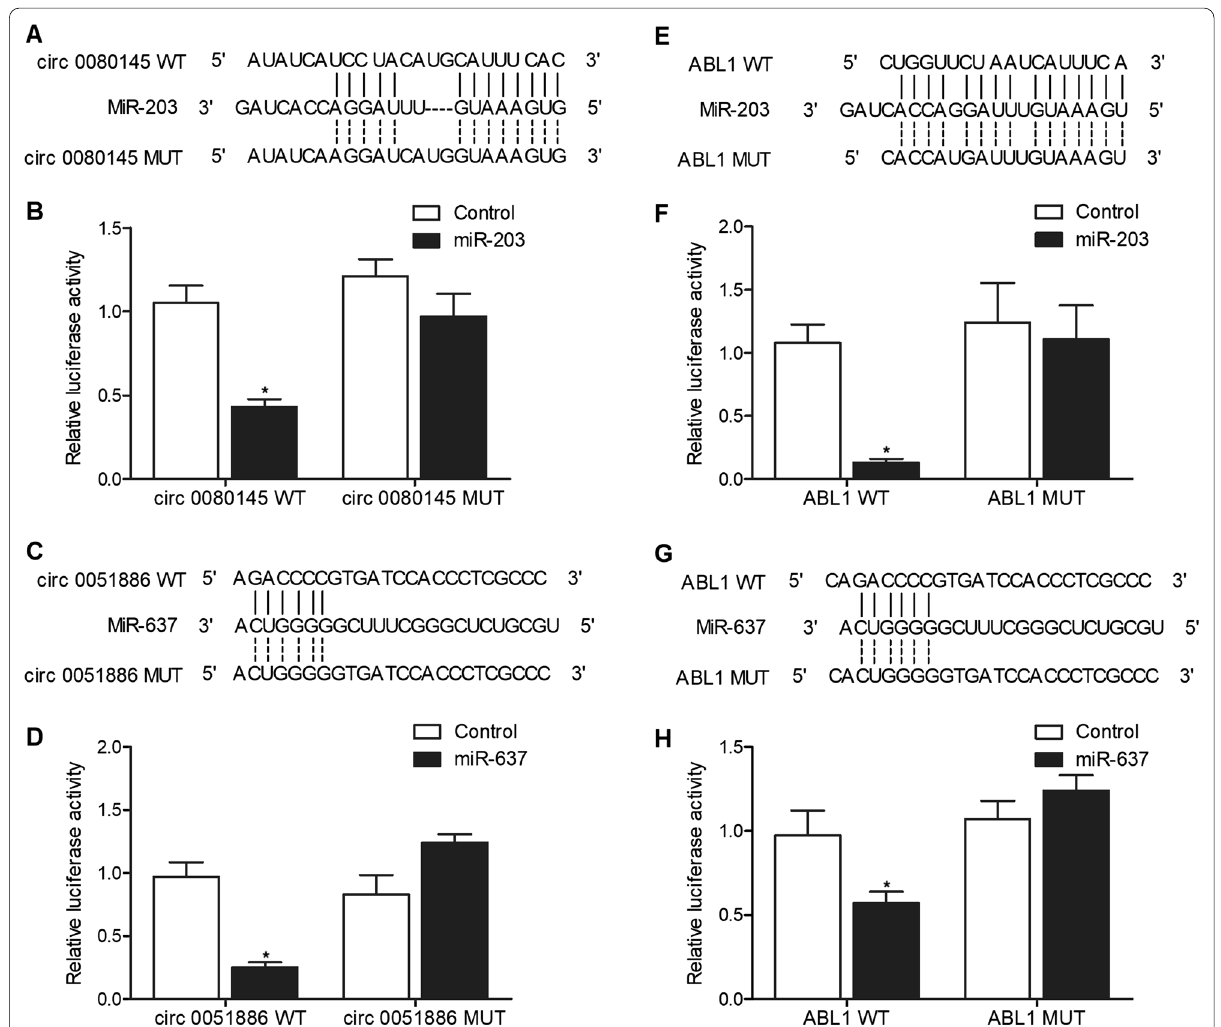
Fig. 3 The molecular relationships between circ_0080145, miR‑203 and ABL1, as well as circ 005188, miR‑637 and ABL1, were established via sequence analysis and luciferase assays (*P value < 0.05 vs. Control group). A A potential binding site of miR‑203 was found on circ_0080145; B Luciferase assay validated that circ_0080145 targeted miR‑203; C A potential binding site of miR‑637 was found on circ 0051886; D Luciferase assay validated that circ_0051886 targeted miR‑637; E A putative binding site of miR‑203 was observed on the 3 ʹ UTR of ABL1 mRNA; F Luciferase assay validated that ABL1 mRNA was a target of miR‑203; G A putative binding site of miR‑637 was observed on the 3 ʹ UTR of ABL1 mRNA; H Luciferase assay validated that ABL1 mRNA was a target of